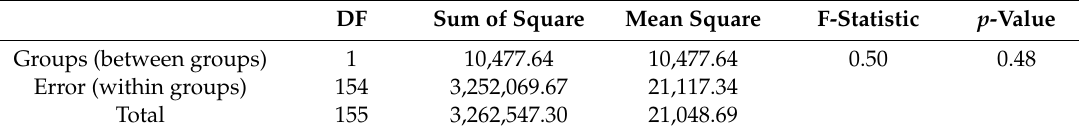
Table 12. Assumptions of normal distribution and homogeneity of variances. DF Sum of Square Mean Square F-Statistic p -Value Groups (between groups) 1